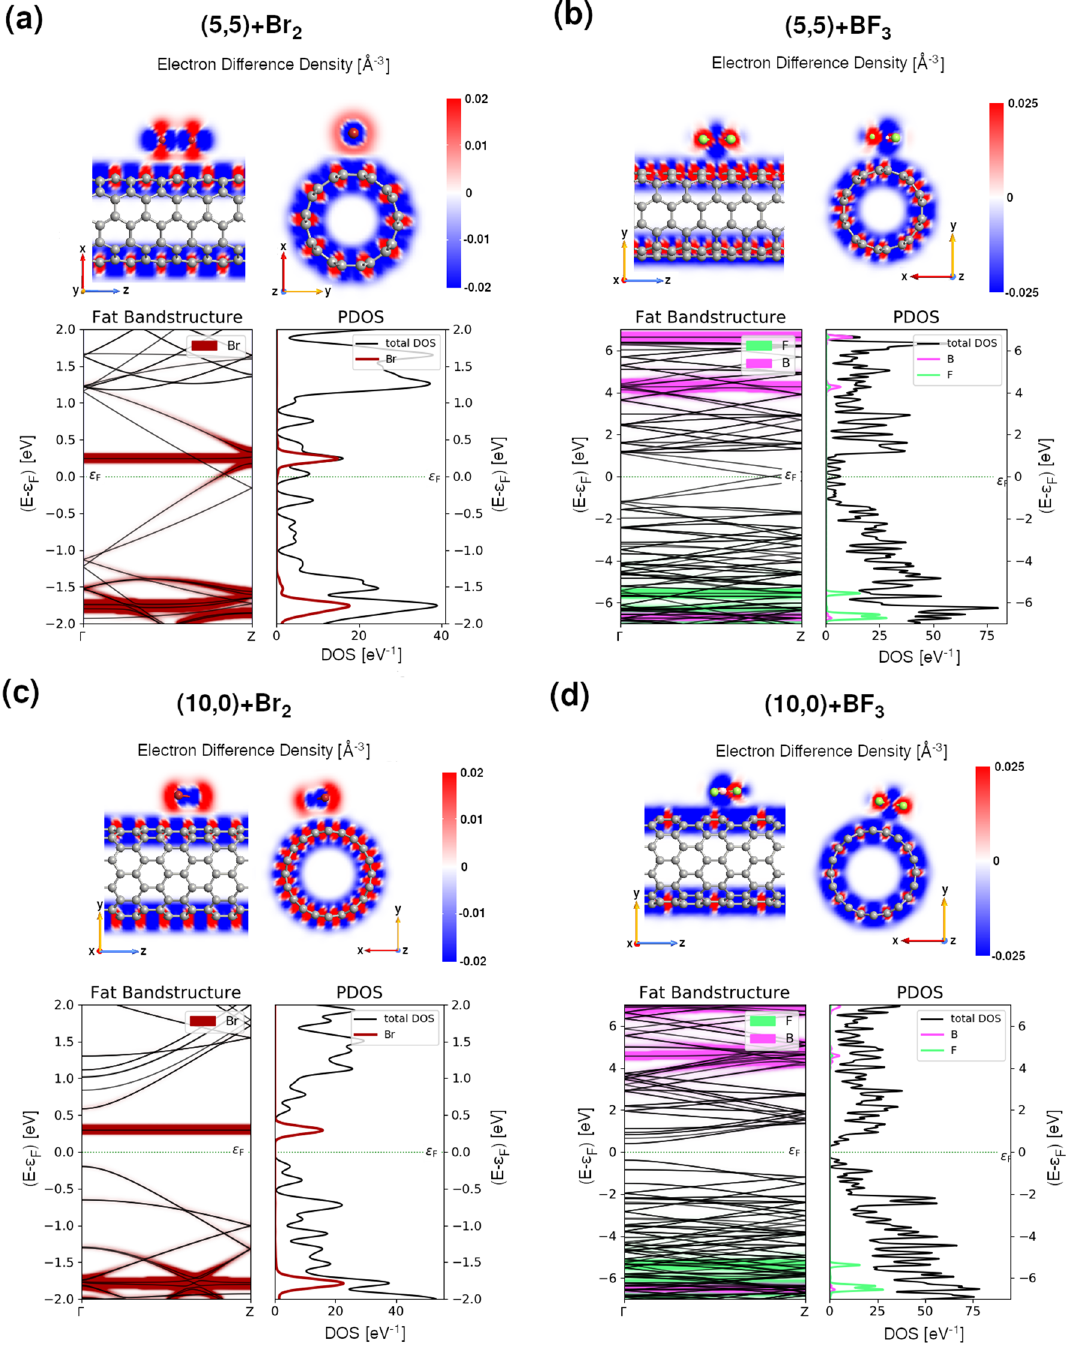
Figure 10. Computed electronic properties of (5,5) and (10,0) CNTs interacting with ( a , c ) Br 2 and ( b , d ) BF 3 molecules, respectively. (top panels) The electron different densities and (bottom left panels) fat band structures along Γ → Z of the Brillouin zone together with the projected density of states on chosen atomic species (PDOS) (bottom right panels). Br atoms are depicted in red while B, F and C atoms are shown in pink, light green, and grey, where G m(s) and S m(s) are the conductances and Seebeck coefficients of systems presented in Fig. 9a,b, respectively. Even though this model neglects CNTs-CNTs junctions 67 , inelastic electron scattering and electron localization effects 65 , the computed electrical conductances are only three times higher than the experimental ones, while the Seebeck coefficients are only a factor of 2 smaller than the experimental values. Having described the pristine systems, we can now focus on the effect of halide doping. The influence of halide doping on CNTs was studied using (5,5), (10,0), (12,12) and (20,0) CNTs doped with Br 2 and BF 3 molecules, as shown in Fig. 10 and Fig. S7. The doping concentrations of small metallic (semiconducting) CNT correspond